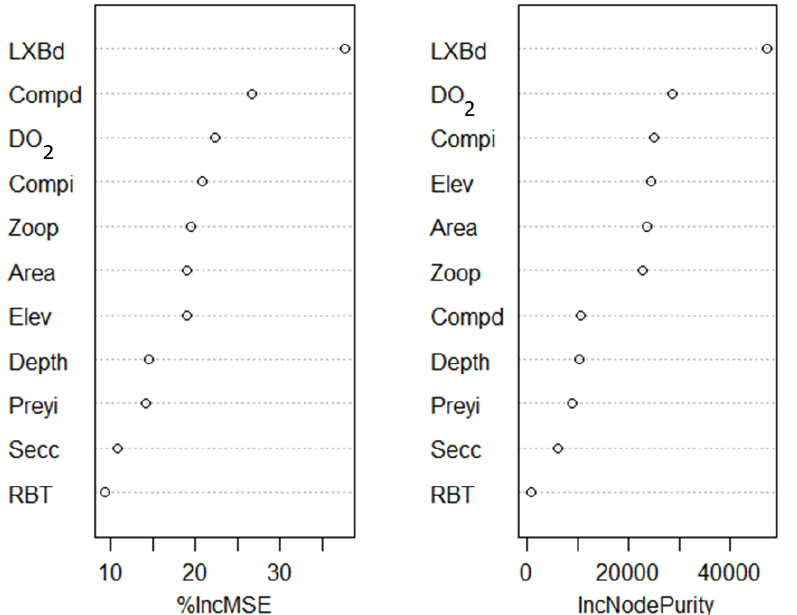
Figure 3. Importance metrics for different variables considered as potential predictors of early tiger trout growth in the Random Forest Model. Predictor variables are ranked for relative importance (top-to-bottom) according to their percent increase in mean square error if removed from the model (%IncMSE; left panel) and in node purity (IncNodePurity; right panel). Predictors included surface area (Area; ha), maximum depth (Depth; m), elevation (Elev; m), dissolved oxygen (DO 2 ; % of water column with DO ≤ 2.0 mg/L), an integrative index of food web structure and early food supply (Zoop; mean biomass density of zooplankton [g dry weight/m 2 ]), cohort-specific tiger trout stocking density (LXB d ; number/ha), an index of interspecific competition (Comp d : stocking density [number/ha] of other salmonid sport fish in the same year as tiger trout), a field-based index of interspecific competition (Comp i : catch rates [number fish/hour] of non-tiger trout in gill nets during 2017), a legacy index of stocking large salmonid sport fish (RBT; presence or absence of stocking ≥ 225 mm fish in recent history), and an index of prey fish availability (Prey i ; number fish/hour of non-tiger trout captured additively in micro-mesh gill nets and miniature trap nets during 2017).